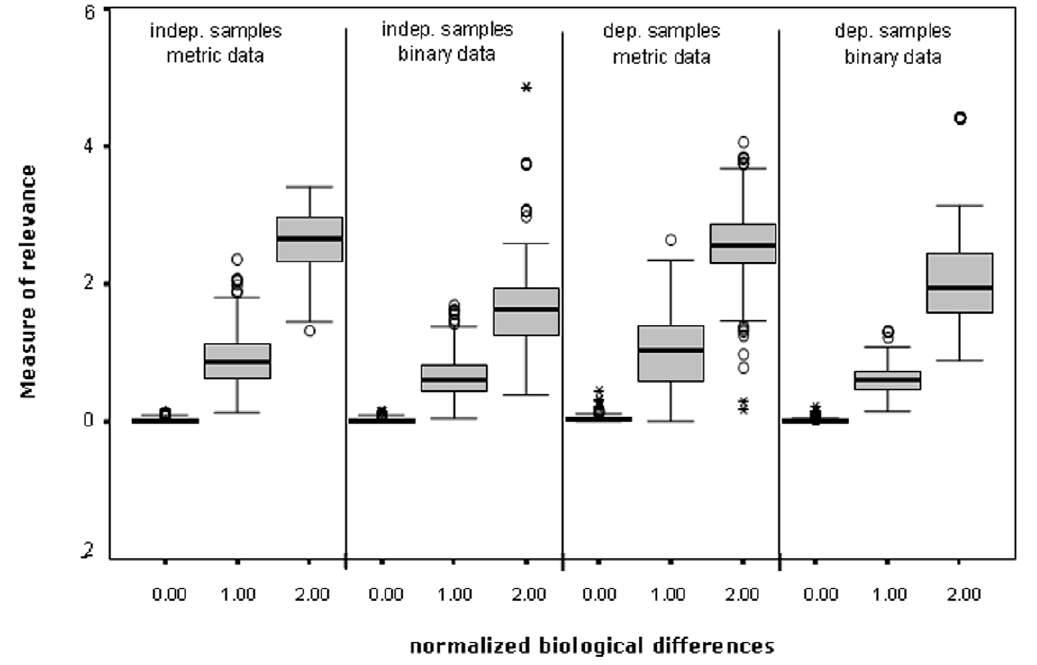
Figure 3. Boxplots of the MoR values under diverse sample designs and data structures. Irrespective of data type and sample design in the two-sample problem, the measure of relevance shows similar values if the variables are very informative (Normalized Biological Difference (NBD) about 2 : 0 ), semi-informative (NBD about 1 : 0 ) or non-informative (NBD about 0 : 0 ).